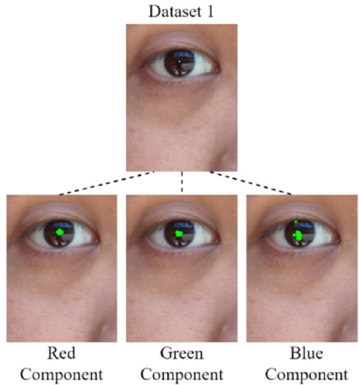
Figure 22. Image from Data Set 1.